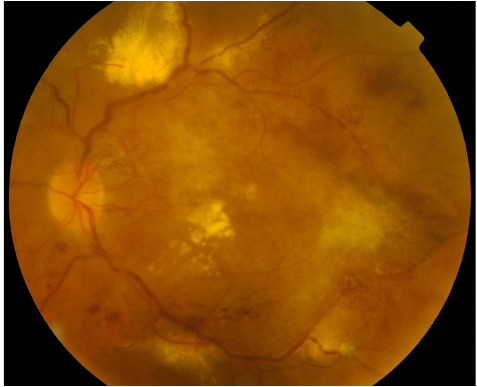
FIGURE 3. Case B. Retinal changes in the LE include extensive lipid exudate deposition in the macular area and superior temporal arcade, dot and blot intraretinal hemorrhages, and deep, shapeless subretinal hemorrhages. There is also marked venous beading and multiple new vessels around the optic nerve and both temporal arcades. Macular retina is thickened, suggesting the presence of macular